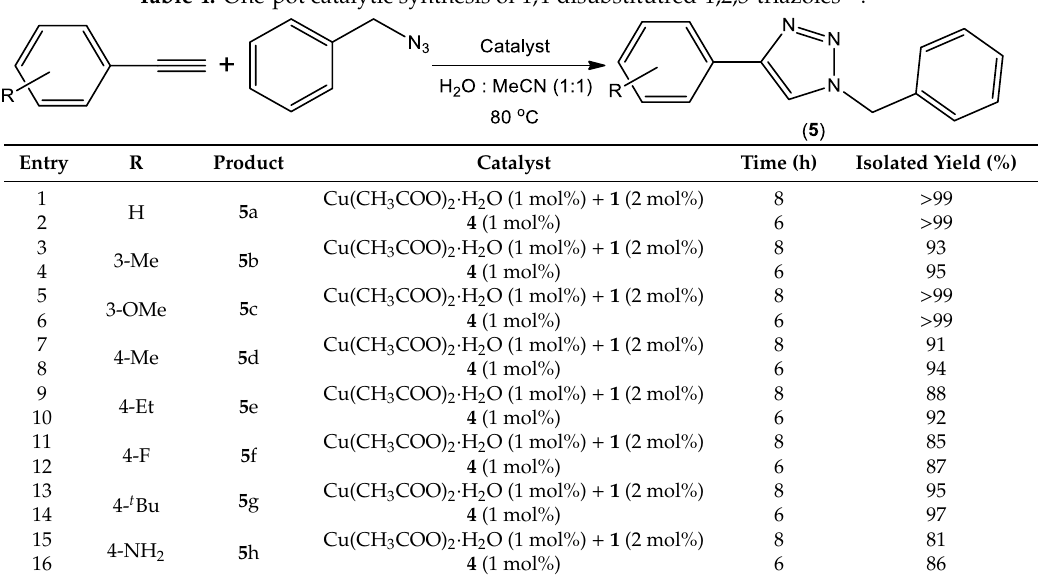
Molecules 2020 , 25 , x FOR PEER REVIEW 11 of 17 Table 4. One-pot catalytic synthesis of 1,4-disubstitutred-1,2,3-triazoles a. Table 4. One-pot catalytic synthesis of 1,4-disubstitutred-1,2,3-triazoles a. .